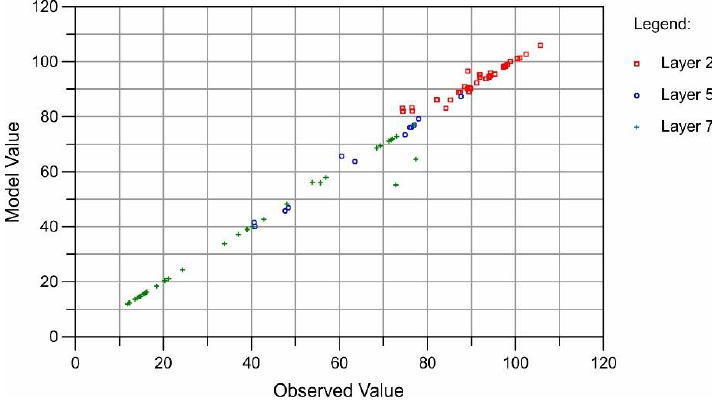
Figure 18. Calibration graph of registered and calculated piezometric head at observation points in June 2015.